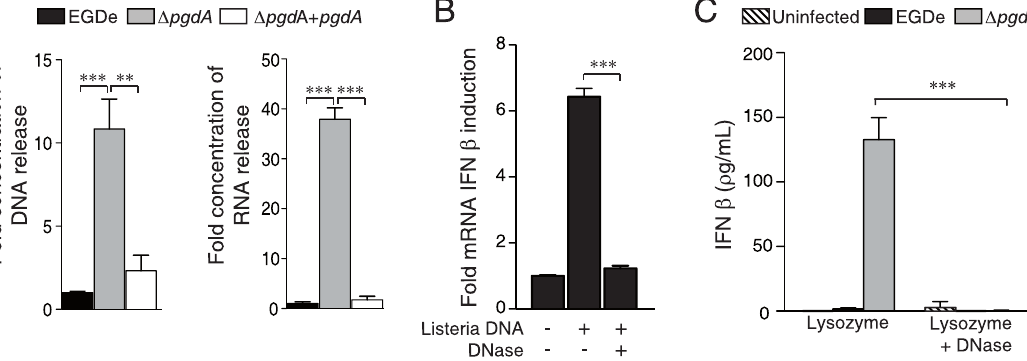
Figure 8. Listeria nucleic acids trigger IFN- b production. (A) The parental EGDe (black bars) D pgdA (grey bars) and complemented D pgdA strain (hatched bars) were incubated with lysozyme. The amount of DNA and RNA released after treatment was quantified by spectrophotometry. (B) THP-1 macrophages were transfected with DNA from the D pgdA mutant, pretreated or not with DNase, and IFN- b induction was determined using the HEK- blue assay. (C) The parental EGDe strain (black bars) or the D pgdA mutant (grey bars) were incubated with lysozyme. PEM were transfected with bacterial lysates, pretreated with DNase or not treated, and IFN- b production was quantified in cells supernatants 24 h after transfection by ELISA. Data are mean 6 SD (**, p , 0.01, n=3; ***, p , 0.0001, n =3).